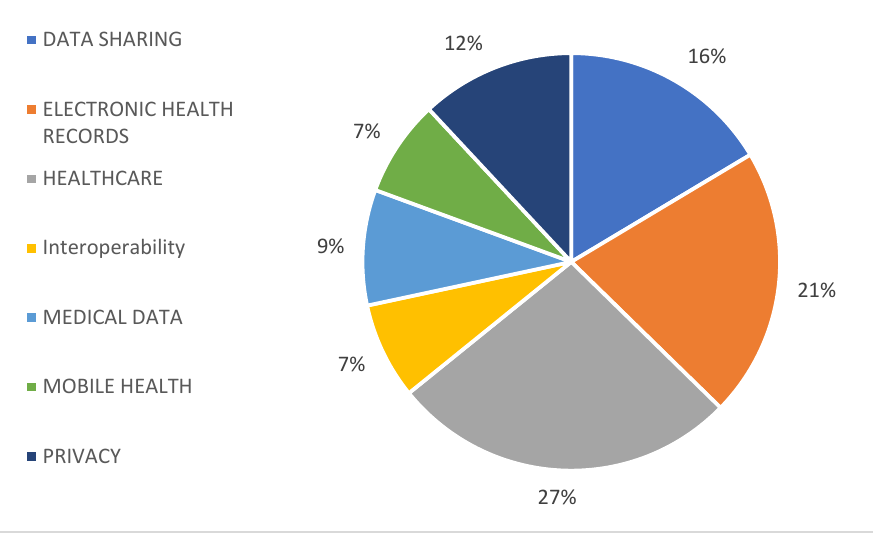
Figure 2. Publications identified based on main topics .